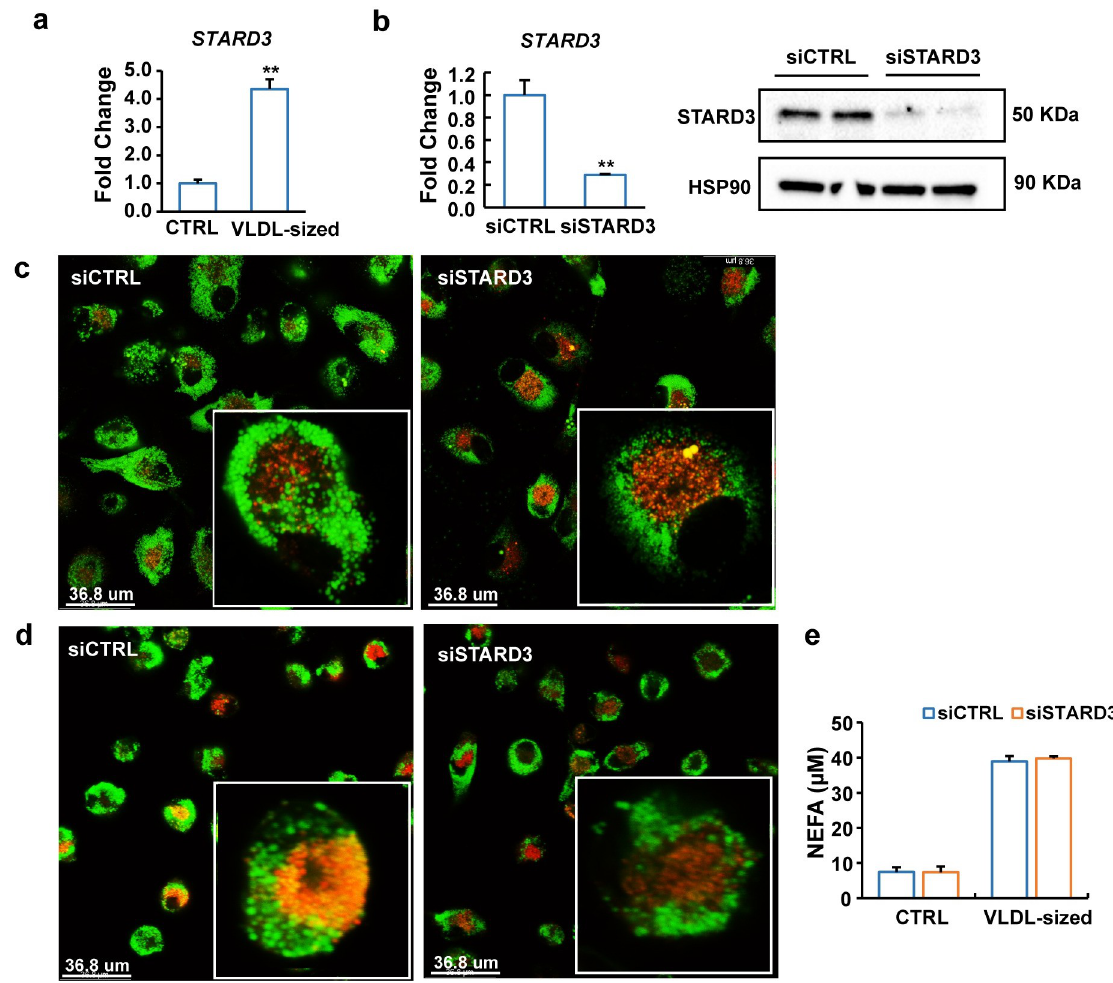
Fig 8. NPC1 and STARD3 have differential roles in the processing of VLDL-sized emulsion particles. (a) mRNA levels of STARD3 in human macrophages after treatment of 1 mM VLDL-sized emulsion particles for 6 hours. Cells were washed twice with PBS and then incubated in fresh medium for 16 hours. (b) mRNA and protein levels of STARD3 in human macrophages treated with siCTRL or siSTARD3 for 24 hours. (c) Co-staining of lysosomes (red) with neutral lipids (BODIPY 493/503, green) in human macrophages treated with siCTRL or siSTARD3 for 48 hours followed by treatment with 0.5 mM VLDL-sized emulsion particles for 24 hours ( n = 6). Thereafter, the cells were washed twice with PBS and incubated in fresh medium without VLDL-sized emulsion particles for 24 hours. (d) Co-staining of ER (red) and neutral lipids (BODIPY 493/503, green) in human macrophages treated with siCTRL or siSTARD3. (e) Non-esterified fatty acid concentration in culture medium from siCTRL or siSTARD3-treated human macrophages. The cells were washed twice with PBS and incubated in fresh medium without VLDL-sized emulsion particles for 16 hours. The bar graphs were plotted as mean ± SD. Asterisk indicates significantly different from control according to Student t test. �� p < 0.01. (The raw data of bar graphs can be found in “S1 Raw Data”.) ER, endoplasmic reticulum; VLDL, very low-density